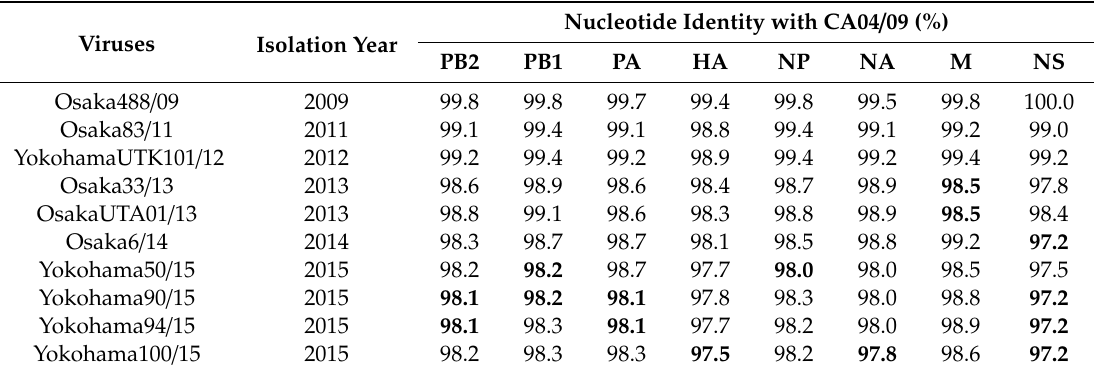
Table 1. Nucleotide identities among the gene segments of the Japanese isolates and those of CA04 / 09 a .